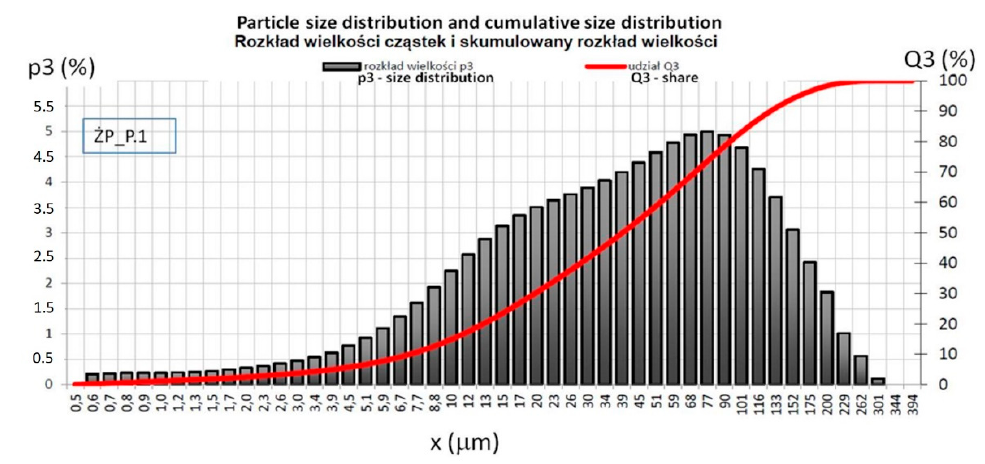
Figure 1. Particle size distribution and cumulative size distribution of LFS.